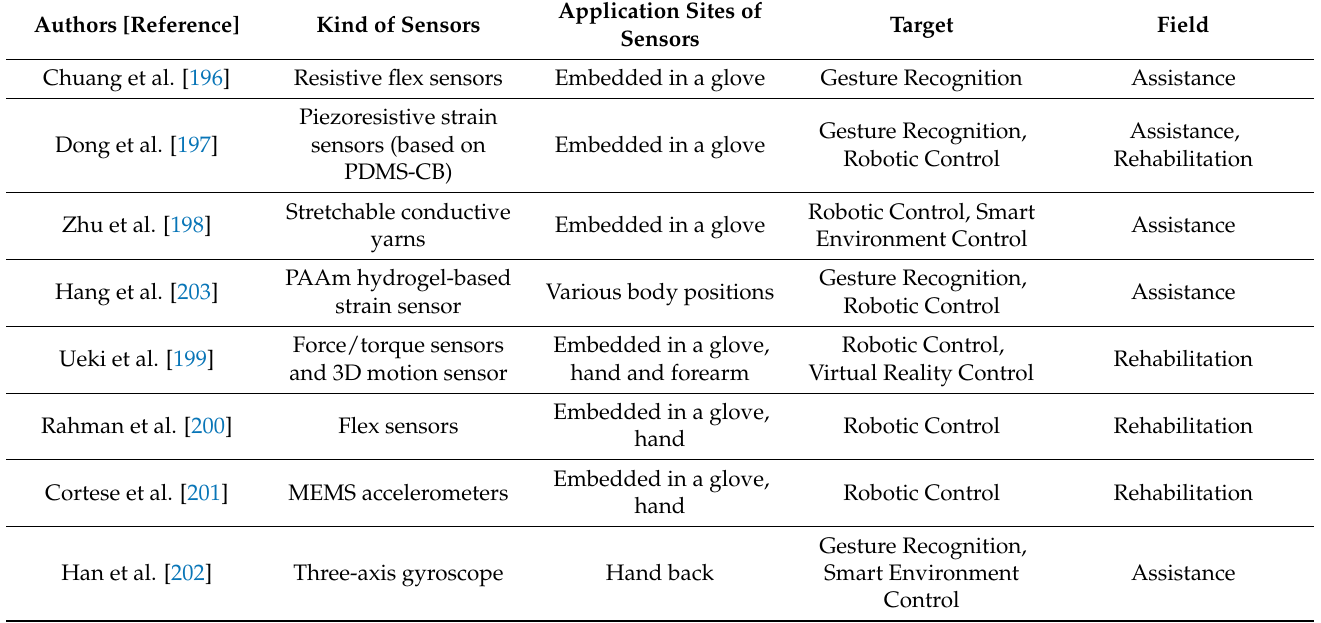
Table 12. Nonimage-based body motion